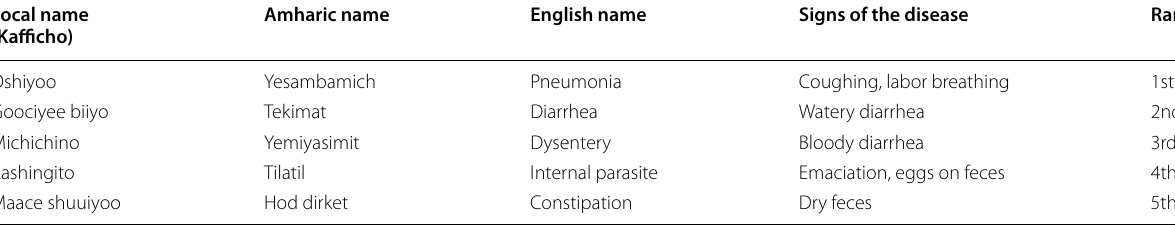
Rank Ranking of lamb diseases based on the frequency of occurrences by animal